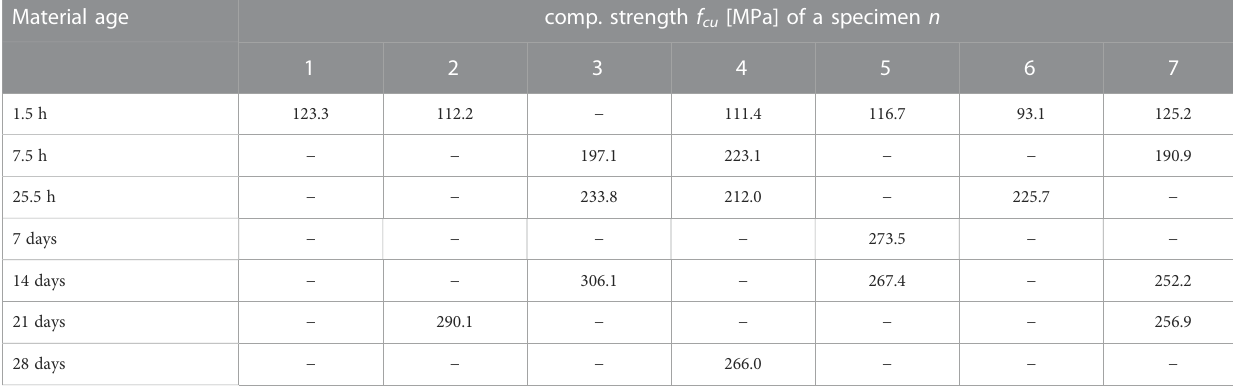
TABLE 5 Compressive strength values of the 4/6 specimens, from tests which were apparently free of signi fi cant imperfections. Material